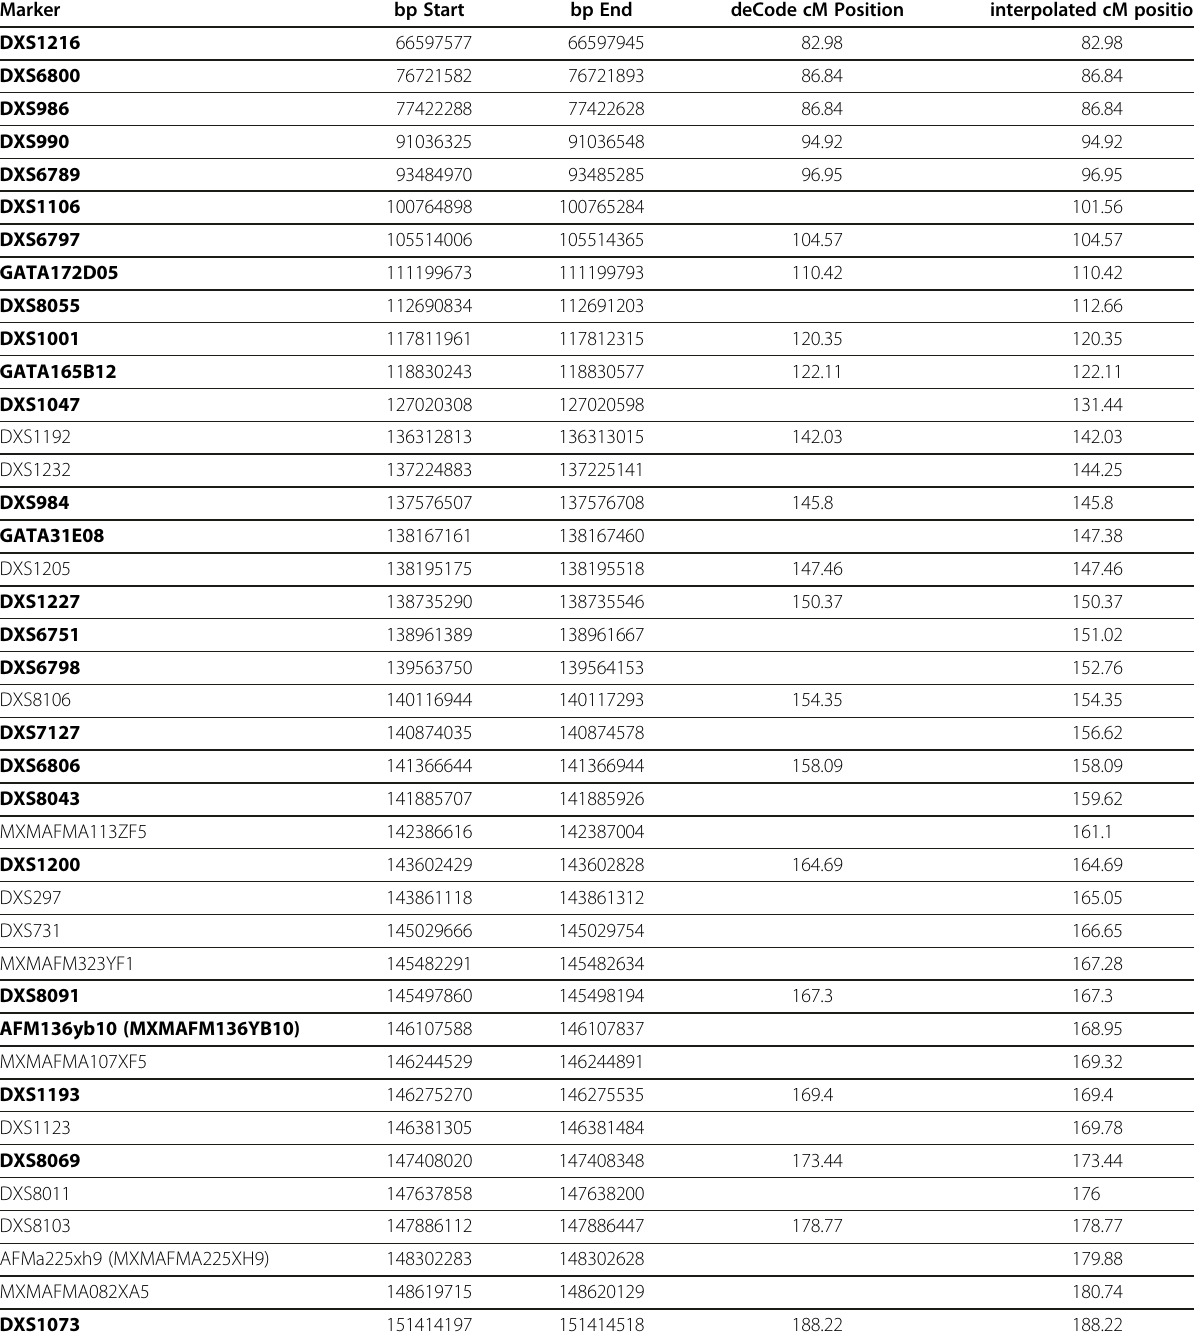
Table 1 Markers used in the analysis with map location information (base pair locations from the UCSC Goldenpath version hg13, released Nov.14.2002 and cM locations from the deCode linkage map)